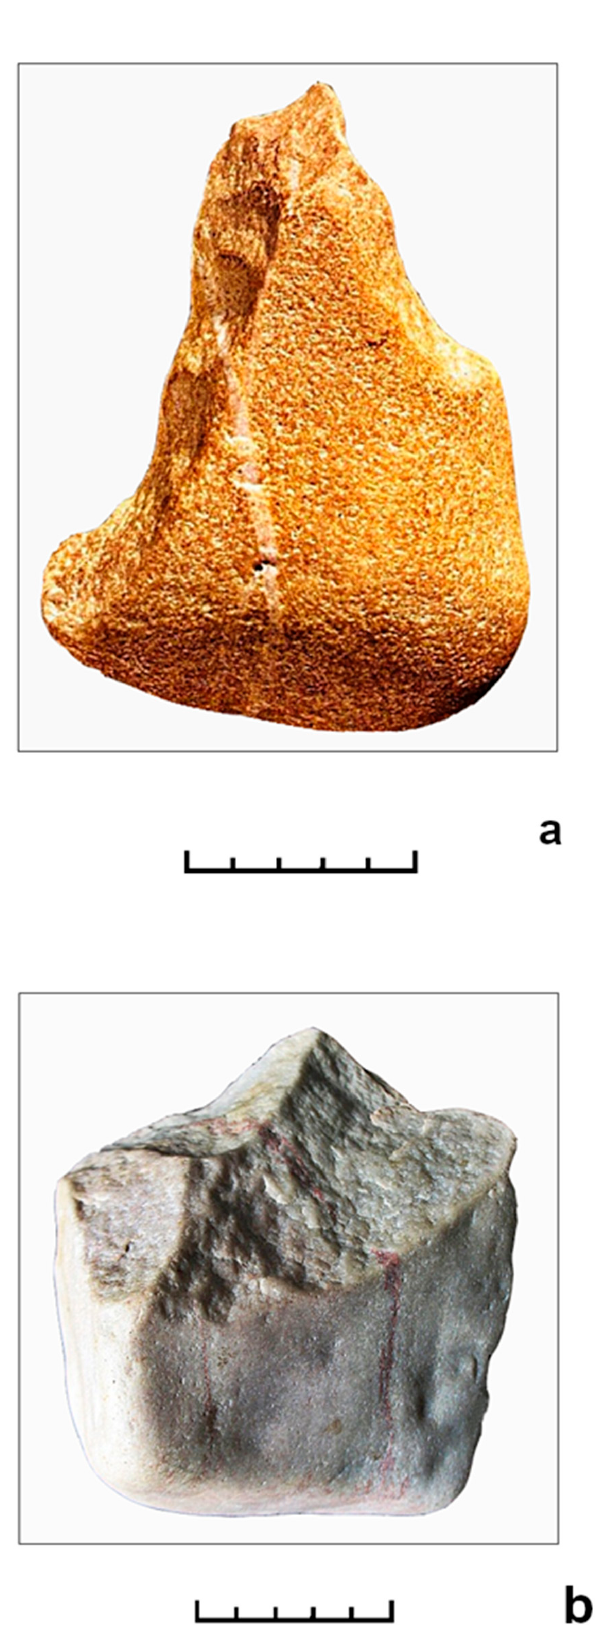
Figure 23. Weeze. ( a ) Pic of the Terra Amata type; ( b ) crude core or pointed chopper; both tools are made out of quartzite. (Photo: H. Klingelhöfer.).